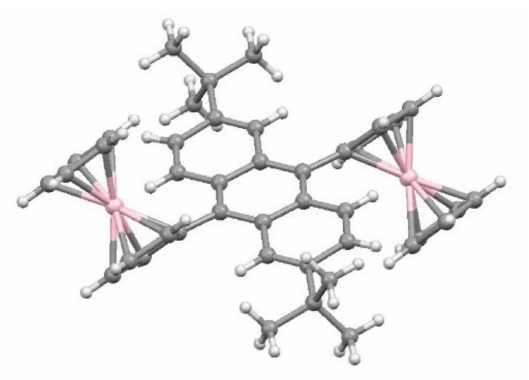
Figure 21. Molecular structure of 2,6-di-tert-butyl-9,10-diferrocenylanthracene, 45 .